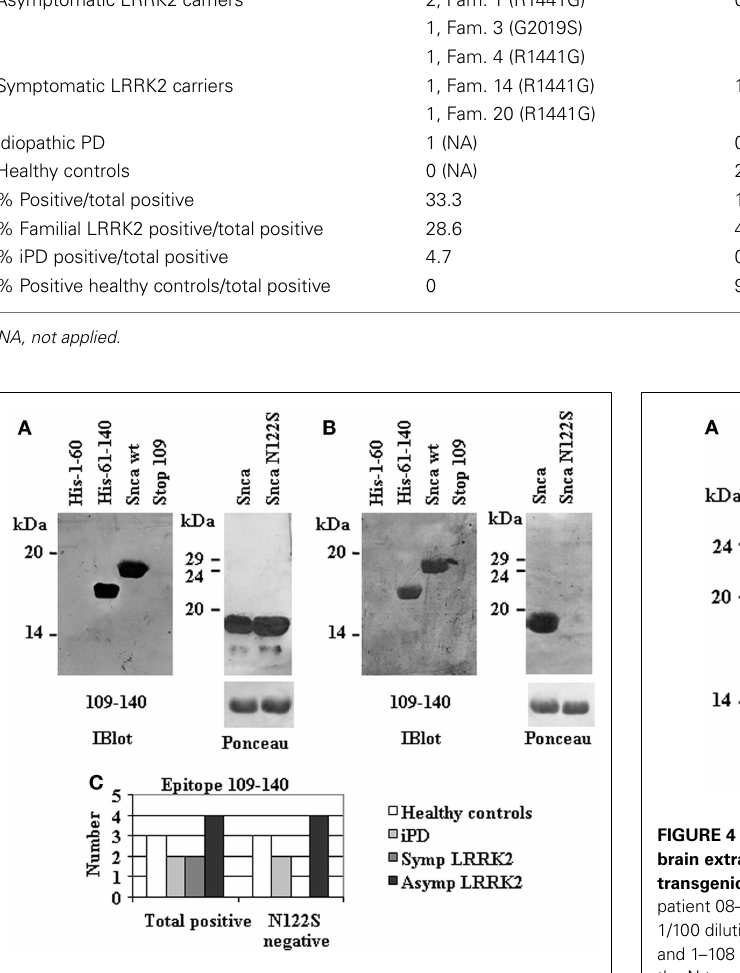
FIGURE 3 | Fine mapping of human anti-Snca antibodies directed against the C-terminal region of Snca (a.a. 109–140) . (A) An example of the reactivity of human anti-Snca antibodies directed against the C-terminal region of Snca (a.a. 61–140) that also recognized Snca full length and the single point mutant Snca N122S. (B) An example of the reactivity of human anti-Snca antibodies directed against the C-terminal region of Snca (a.a. 61–140) that recognized Snca full length, but not the single point mutant Snca N122S. (C) Graph showing the total number of individuals scoring positive for antibodies against the C-terminal region of Snca and those that were negative for the N122S missense mutant within the different groups under study: healthy controls, iPD, and manifesting LRRK2 carriers (SympLRRK2) and non-manifesting LRRK2 carriers (Asymp LRRK2).